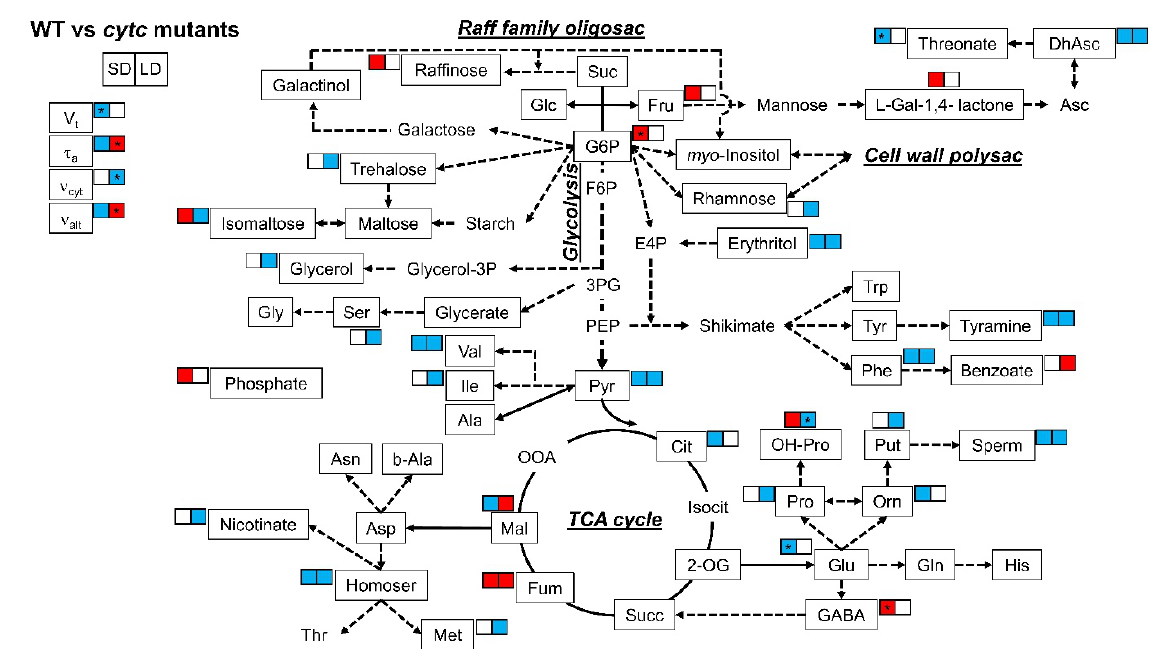
Figure 4. Metabolic model showing comparisons of leaf primary metabolites and respiratory parameters between WT and cytc mutants under SD and LD. Colored metabolites are those showing to be significantly ( p < 0.05) higher (red) or lower (blue), determined by Duncan’s test. For cytc mutants, highlighted metabolites are those displaying consistent changes in both mutant lines as compared with WT in each photoperiod. Data used were taken from Figure 2 and Table 2. See Figure 3 for the abbreviations. * Only one line significantly ( p < 0.05) different from WT but the other line with the same trend and intermediate response.